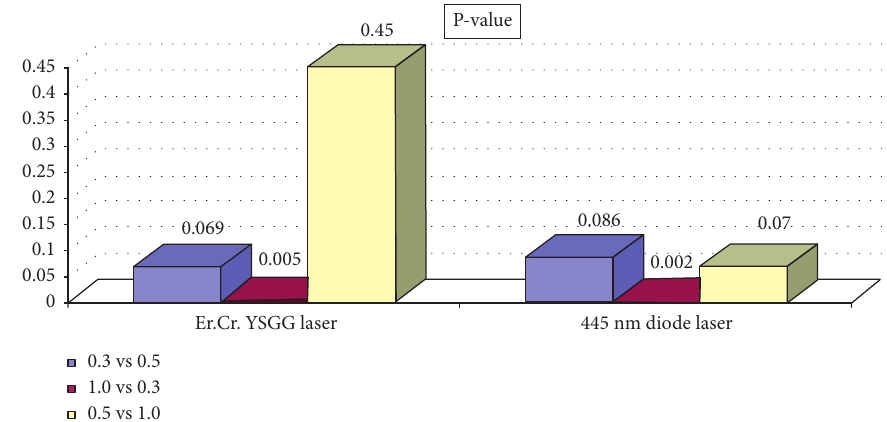
Figure 3: Pair comparison of thickness in two groups of Er, Cr:YSGG and 445nm diode